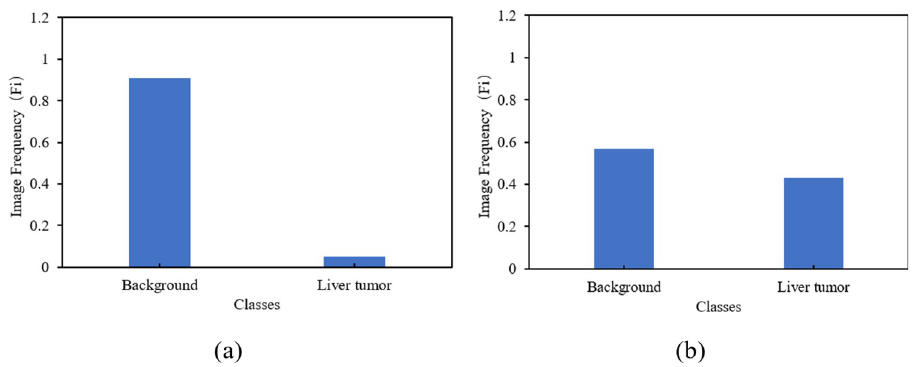
Fig 8. Pixel distribution of (a) original images and (b) after class weighting for the LiTS17 dataset.